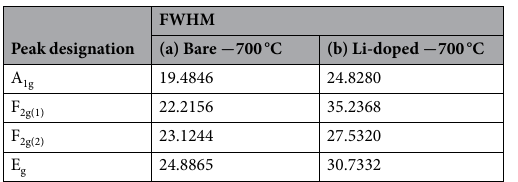
Table 2. Peak designation and FWHM of deconvoluted Raman spectra of the (a) bare − 700 °C sample and (b) Li-doped − 700 °C